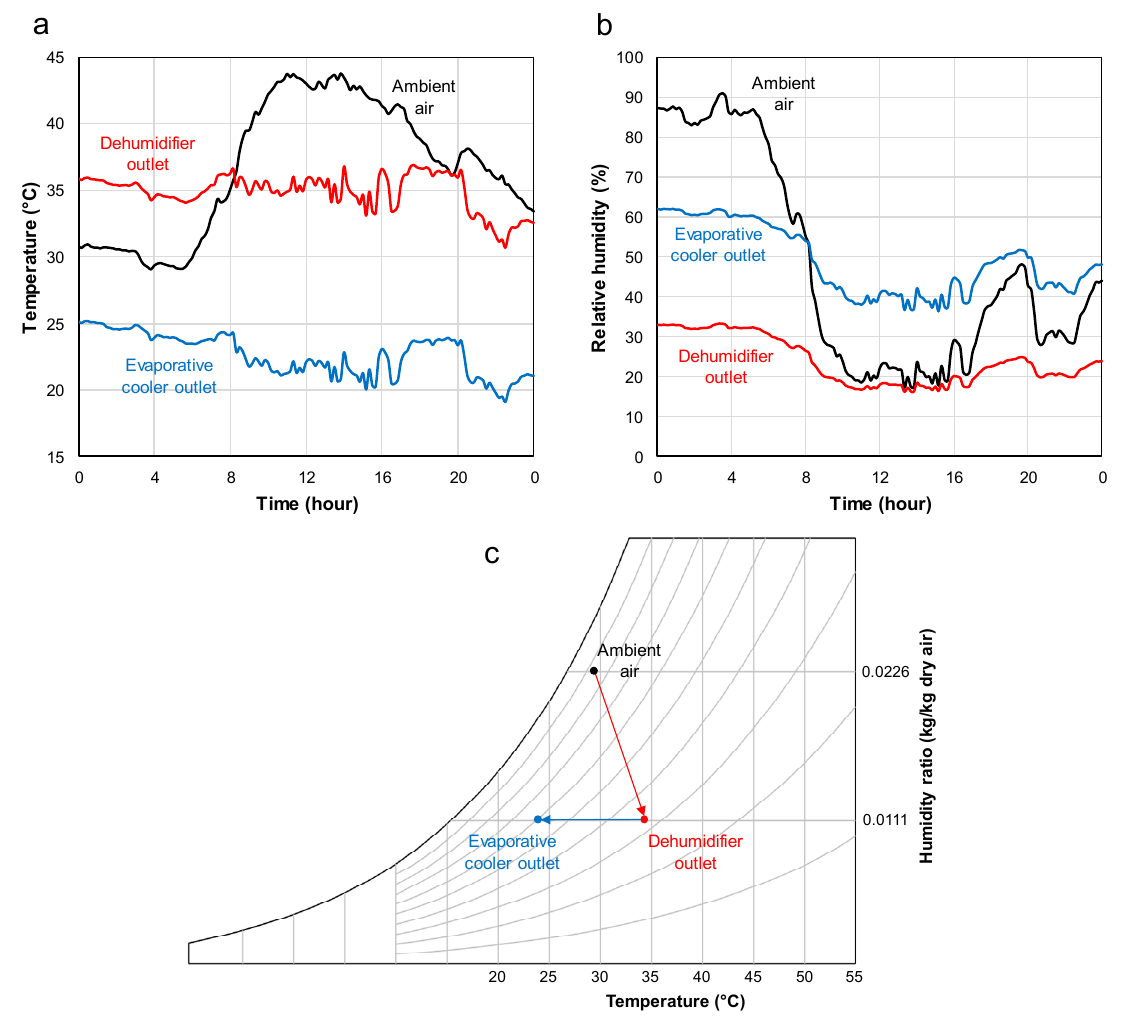
Figure 8. ( a ) Ambient air temperature and ( b ) relative humidity during a humid day (16 June 2017) in Doha, Qatar and the corresponding outlet conditions of the dehumidifier and evaporative cooling system. ( c ) The inlet and outlet air conditions of the dehumidifier and the evaporative cooler on a psychometric chart at 4 AM.